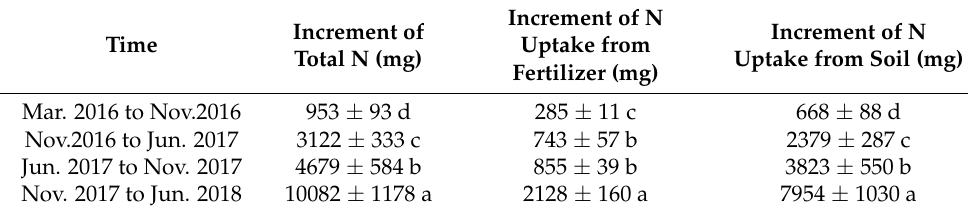
Table 4. The increment of total N of pear trees, N uptake from the fertilizer and the soil from March 2016 to June 2018. Increment of N Increment of N Increment of Uptake from Time Uptake from Soil (mg) Total N (mg) Fertilizer (mg) Mar. 2016 to Nov.2016 953 ± 93 d 285 ± 11 c 668 ± 88 d Nov.2016 to Jun. 2017 3122 ± 333 c 743 ± 57 b 2379 ± 287 c Jun. 2017 to Nov. 2017 4679 ± 584 b Nov. 2017 to Jun. 2018 10082 ± 1178